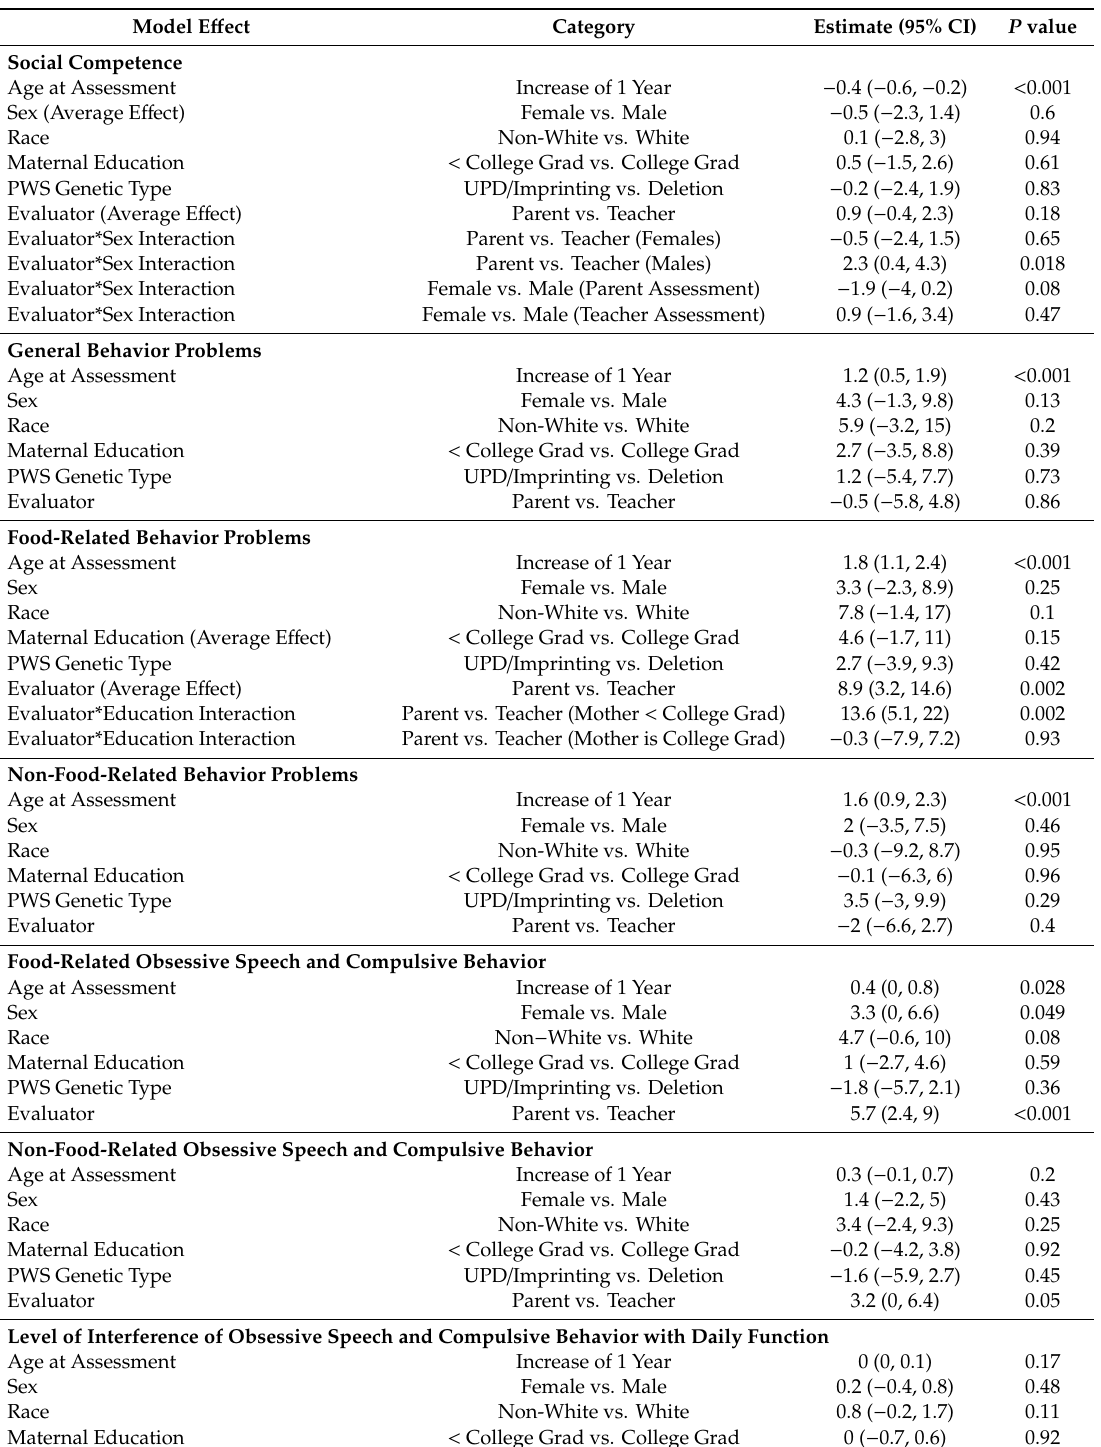
Table 3. Model Results for GAIB